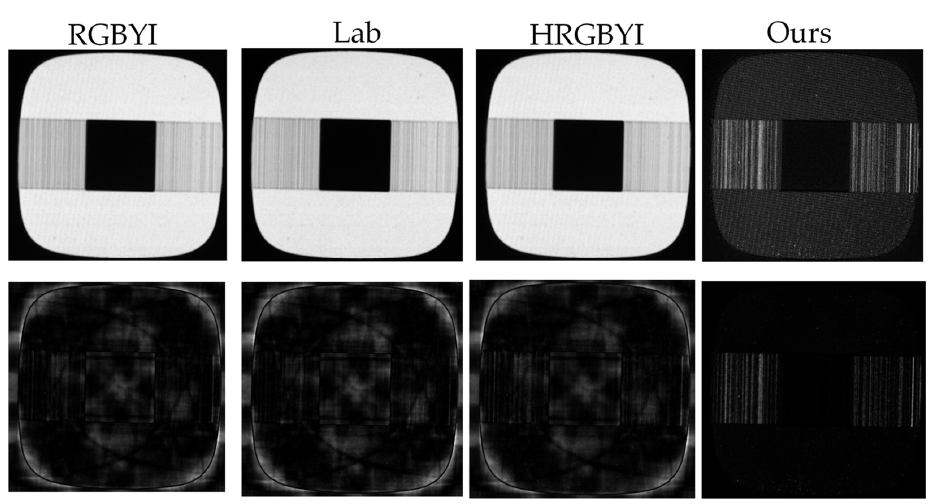
Figure 7. Combined feature saliency result graph: the first row is the quaternion modulo image, and the second row is the result saliency graph.